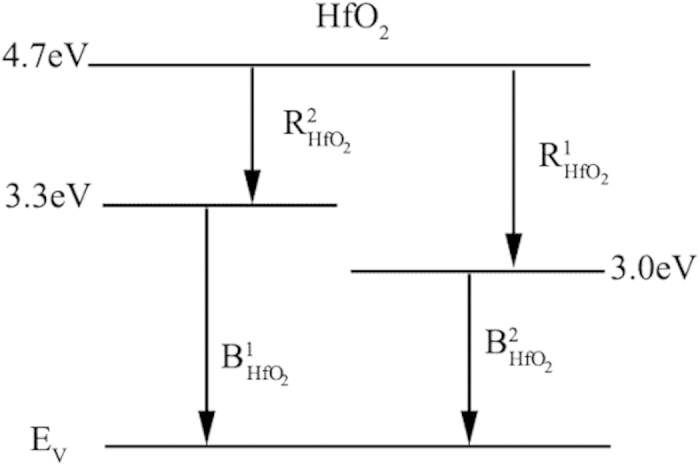
Schematic diagram for the light emission from HfO2 by the transitions in the energy levels of defect states.